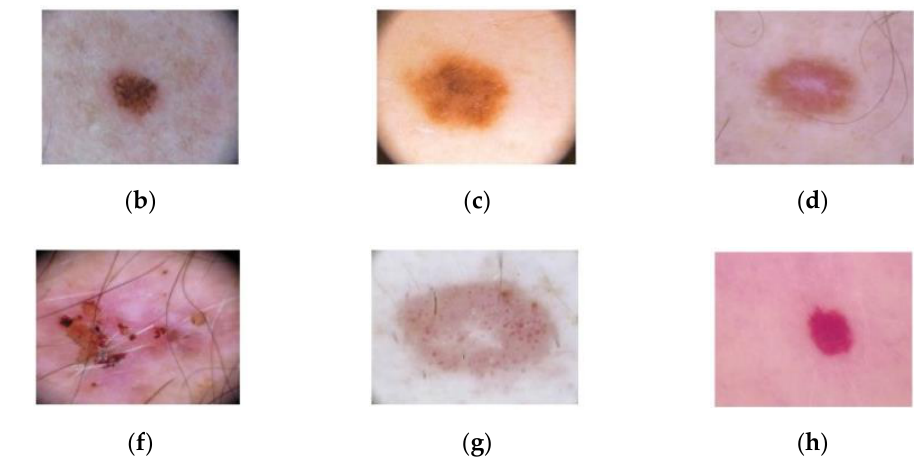
Figure 5. Dermoscopic images from ISIC-2019 database. ( a ) Squamous cell carcinoma; ( b ) Nevus; ( c ) Melanoma; ( d ) Dermofibroma; ( e ) Benign keratosis; ( f ) Basal cell carcinoma; ( g ) Actinic keratosis; ( h ) Vascular lesion.